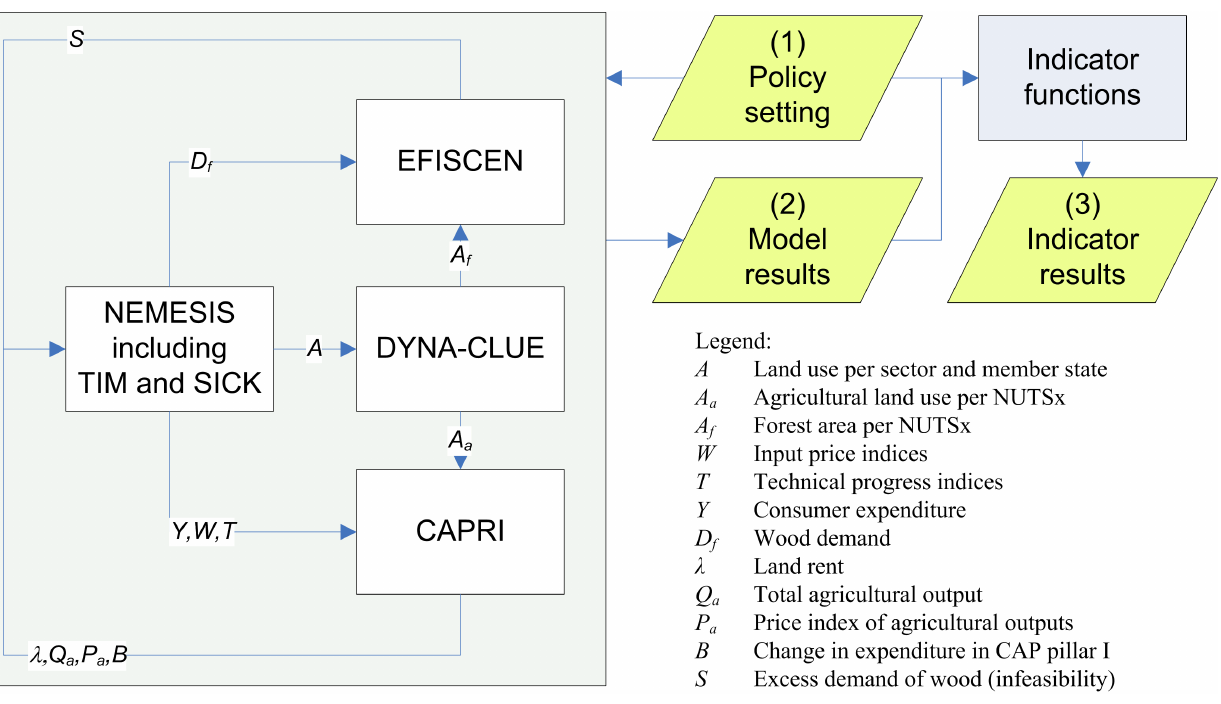
Fig. 2 . Information flow, from policy to indicators, within the modeling system (from Jansson et al.